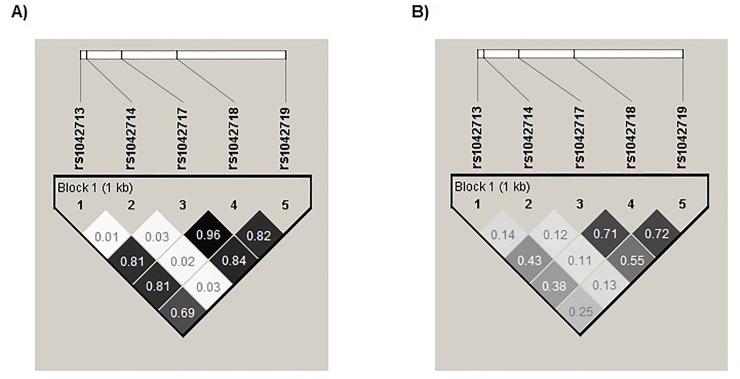
Linkage disequilibrium (LD) structure of ADRB2 SNPs in A) MAs and B) MEZs. The r2 value was calculated using Haploview software 4.2.